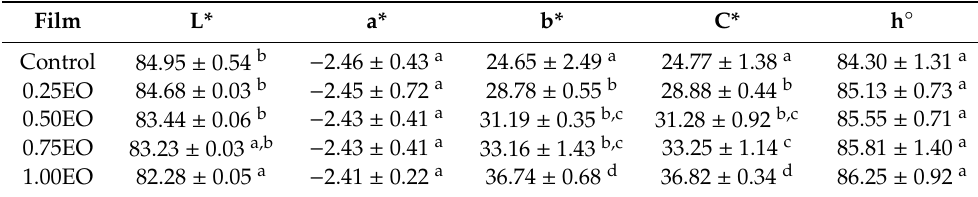
Table 3. Color parameters of chitosan films with Citrus limonia essential